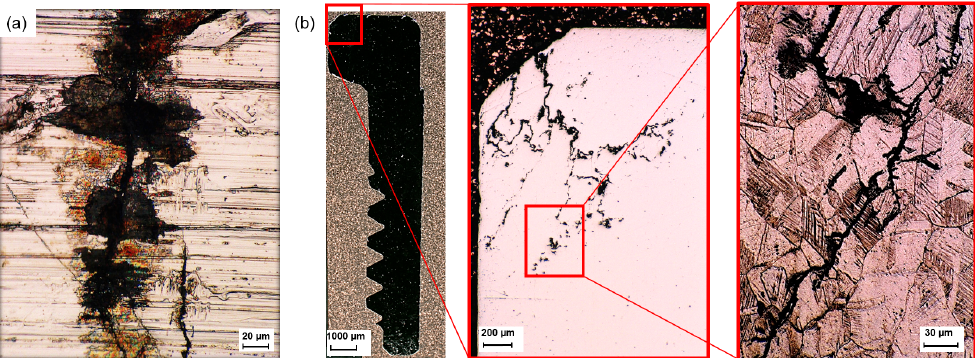
Figure 4. Different forms of cracks. ( a ) Crack nucleated at the pitting corrosion site on the annulus surface of SPT. ( b ) Crack branched out transgranularly under the chamfer surface of